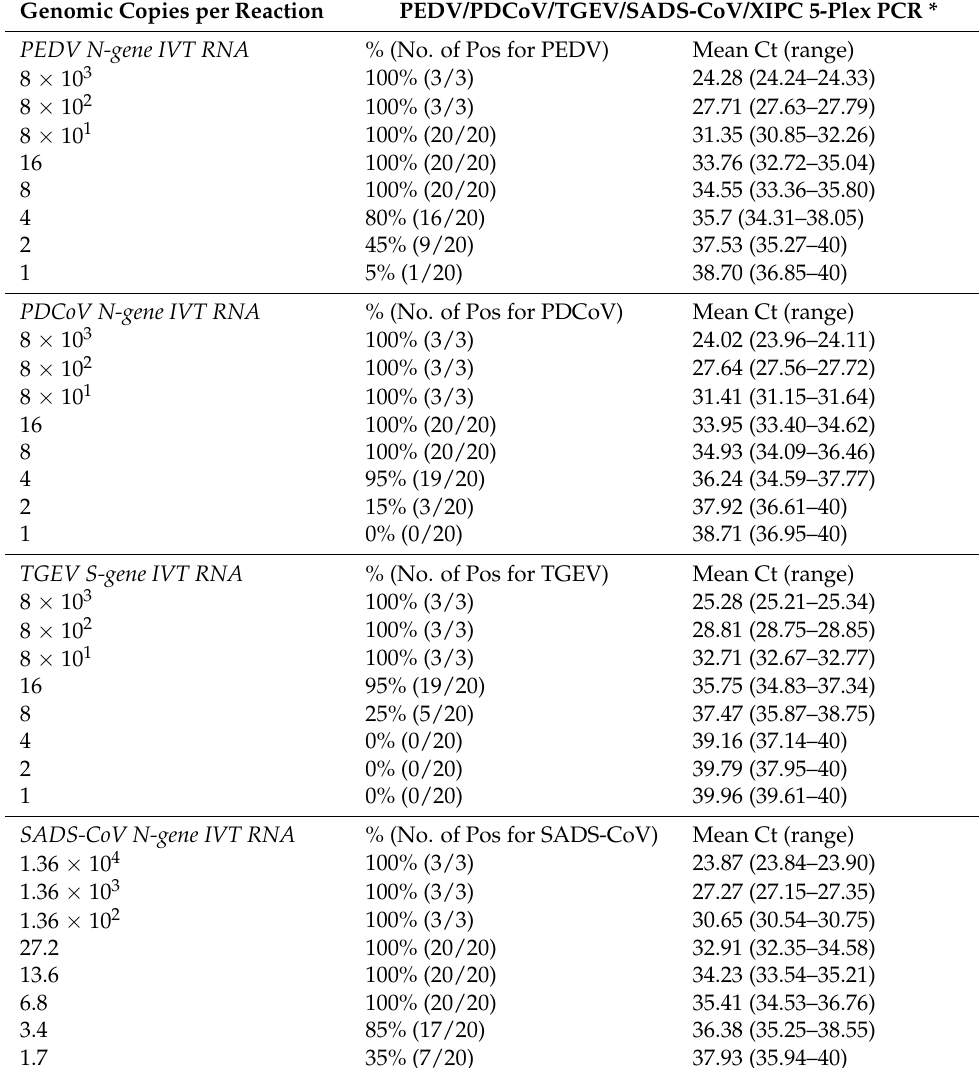
Table 6. Limit of detection of PEDV/PDCoV/TGEV/SADS-CoV/XIPC 5-plex PCR by testing serial dilutions of IVT